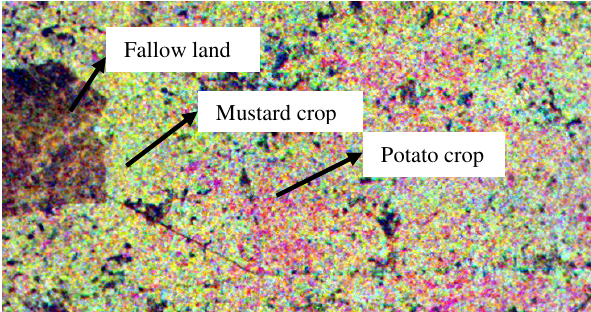
Figure 2a Multidate RISAT-1 FCC showing various